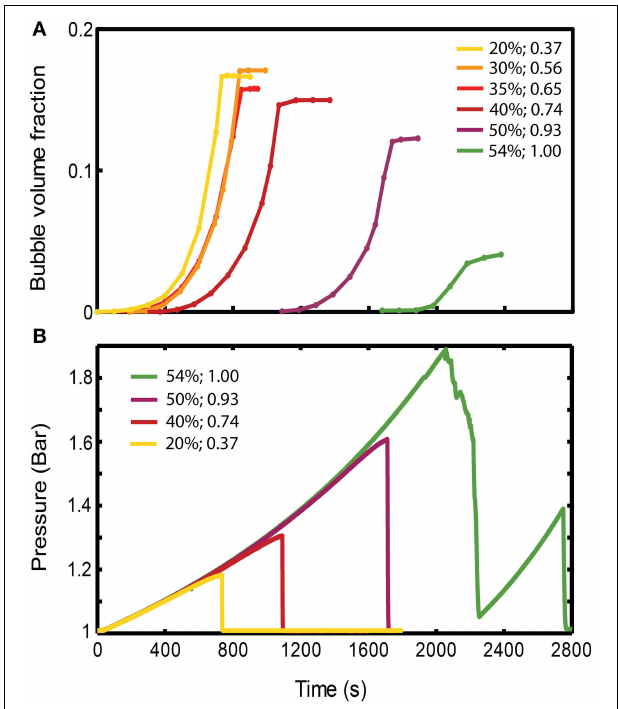
FIGURE 4 | (A) Evolution of gas volume fraction at various particle concentrations for bubble injection experiments in small-gap Hele-Shaw cells. The gas volume fraction, calculated as V gas /V total , is a measure of bulk growth normalized by the total volume. The plateau indicates that a finger has reached the edge, creating an open channel for gas flow, and the gas volume fraction in the experiment cannot grow any further. (Viscosity ≈ 50 Pa s, gas influx = 52mL/h, experiments with ∼ symmetrical fingers). (B) Pressure values at the inlet, reflecting the delay in outgassing experienced by the more particle-rich experiments. The outgassing event is characterized by a sudden drop in pressure. Experiments are the same as in (A) . The figure legend shows particle volume fraction (first column), and φ (second column).